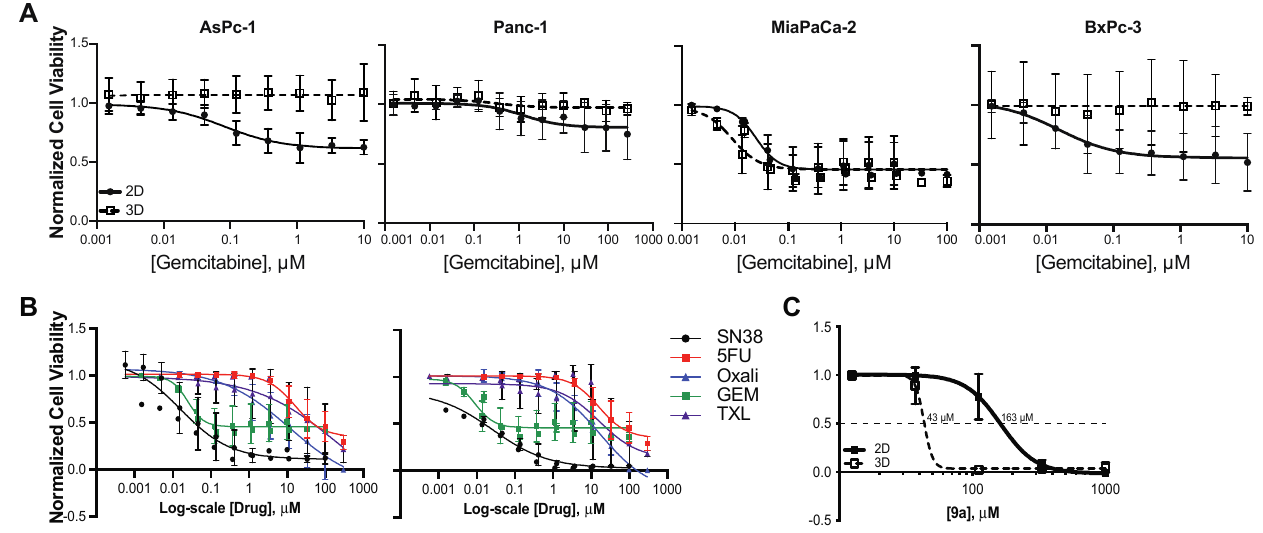
Figure 5. Enhanced sensitivity to compound 9a in 3D MiaPaCa2 cells. ( A ) Pancreatic cancer cells were grown in 2D and 3D cell morphologies and exposed to a range of gemcitabine quantities, μ M, for 72 h. Non–linear regression was performed and changes in IC 50 were compared using the extra sum-of-squares F test. Notably, gemcitabine was cytostatic in all cell lines. In addition, 3D–grown AsPc1, Panc1, and BxPc3 cells were less responsive to gemcitabine, whereas 3D MiaPaCa2 cells demonstrated a 2–fold increase in sensitivity. ( B ) A comparison of 2D and 3D-grown MiaPaCa2 cells exposed to an array of chemotherapeutic agents used in the management of pancreatic cancer revealed that the phenomenon of enhancement of cell response in 3D structures was not a uniform feature; there was either no change in response (SN38, 5-FU, GEM, or paclitaxel (TXL)), or a 2–fold decrease in sensitivity (oxaliplatin, Oxali) in the 3D morphology. ( C ) Cytotoxicity of compound 9a was found to significantly decrease in the 3D morphology by a factor of 4, indicating that 3D–grown MiaPaCa2 cells are even more susceptible to changes in KRAS expression. All experiments were completed minimally in triplicate with internal technical duplicates (for C ) or triplicates ( A , B